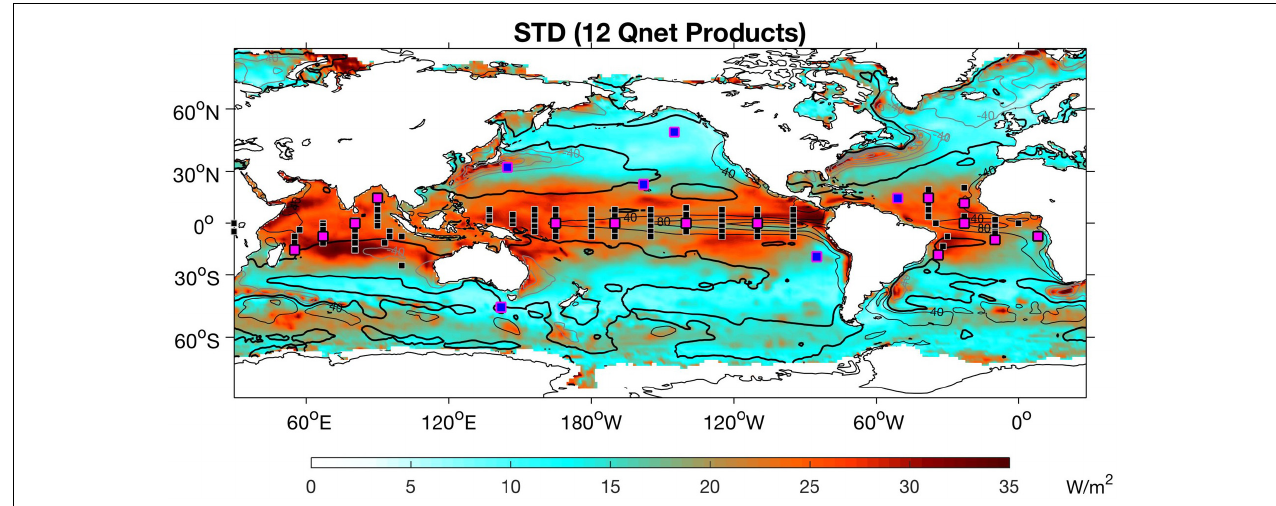
FIGURE 7 | Standard deviations between 12 mean surface heat flux (Q net ) products (colors) superimposed on the ensemble mean Q net (contours; zero lines are highlighted). The means for all products are constructed over the same 10-year period between 2001 and 2010. Black squares denote the tropical moored arrays (PIRATA, TAO/TRITON, and RAMA) with net heat flux reference sites denoted by large magenta squares. Blue squares outlined in magenta denote OceanSITES buoys (NTAS in the tropical Atlantic). Adapted from Yu